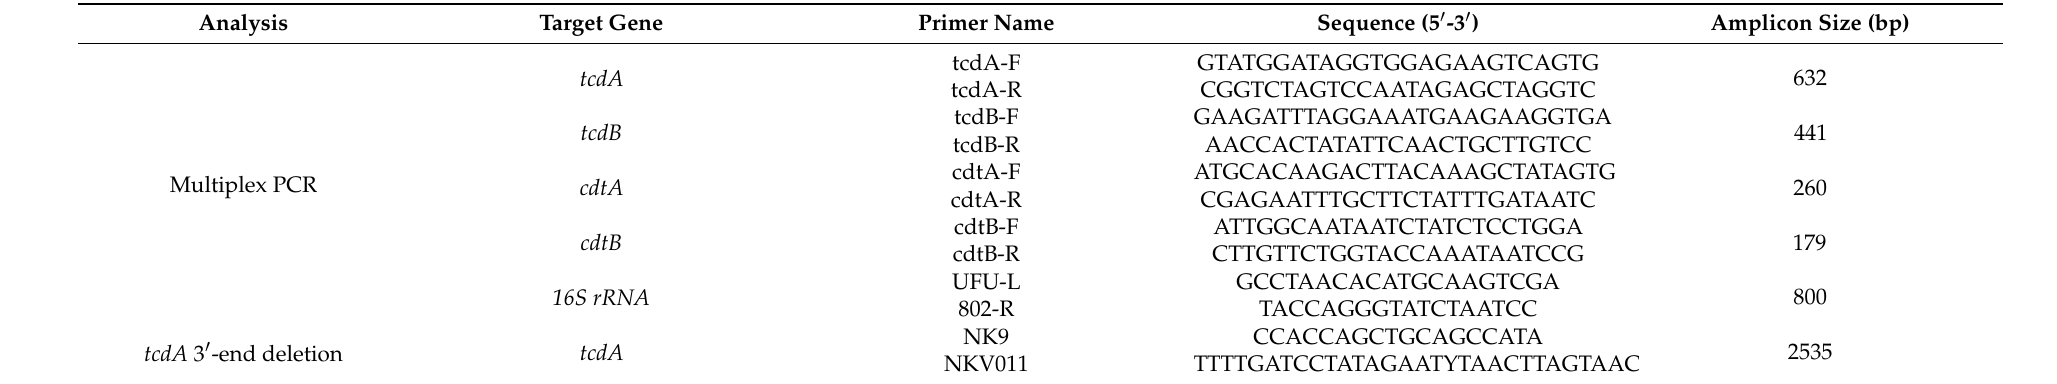
Table 3. Sequences of primers for amplifying toxin genes of C. difficile and amplicon